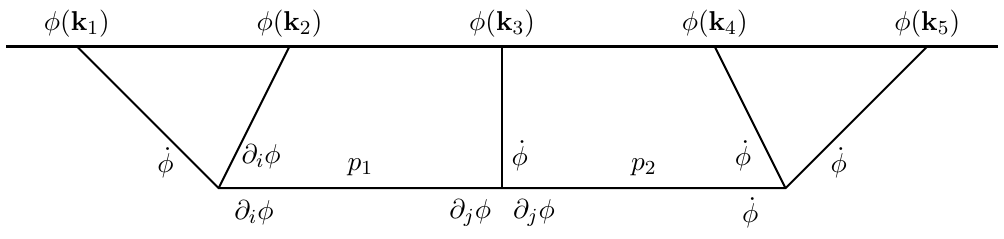
Figure 3 . A particular contribution to the quintic wavefunction coefficient from the indicated cubic